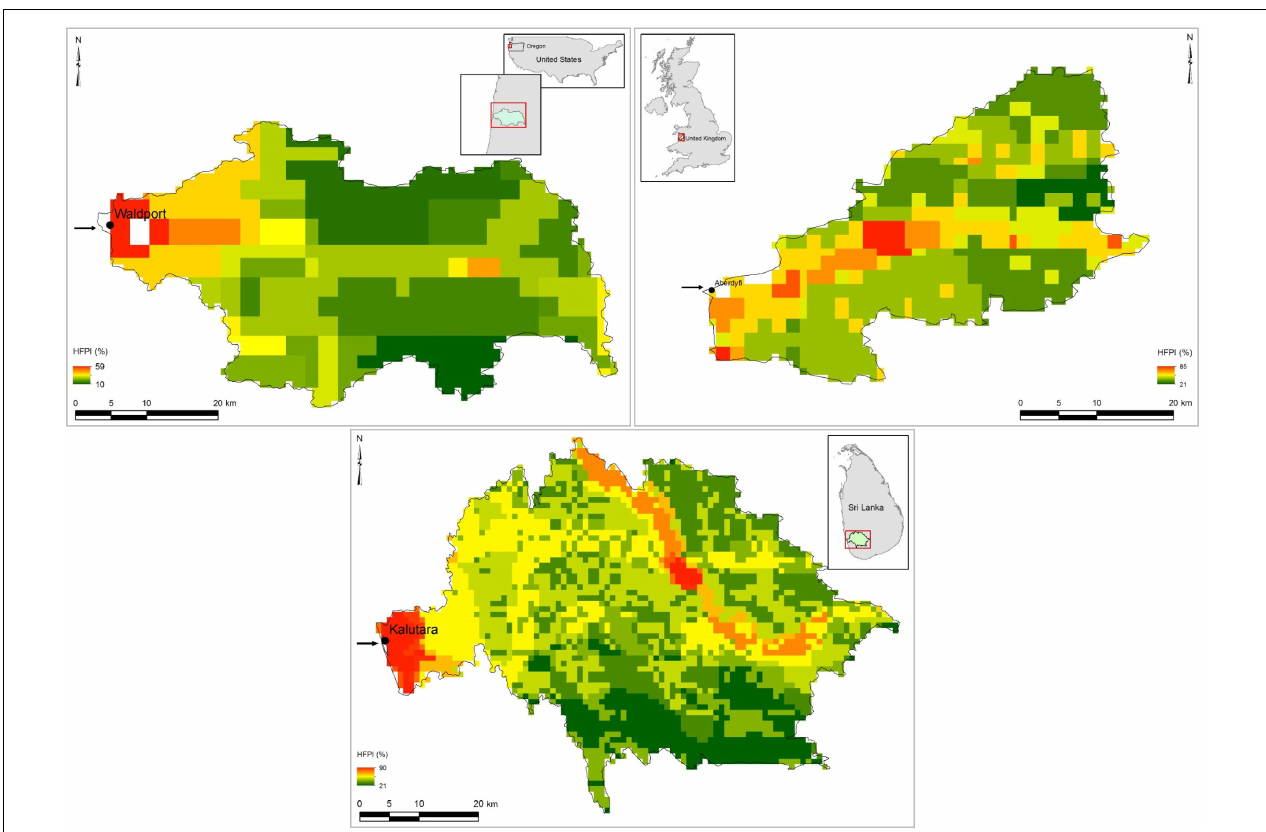
FIGURE 5 | Human FootPrint Index (HFPI), location and watershed areas of the selected CEC systems (Alsea estuary: top-left , Dyfi estuary: top-right , and Kalutara estuary: bottom ). HFPI data were obtained from